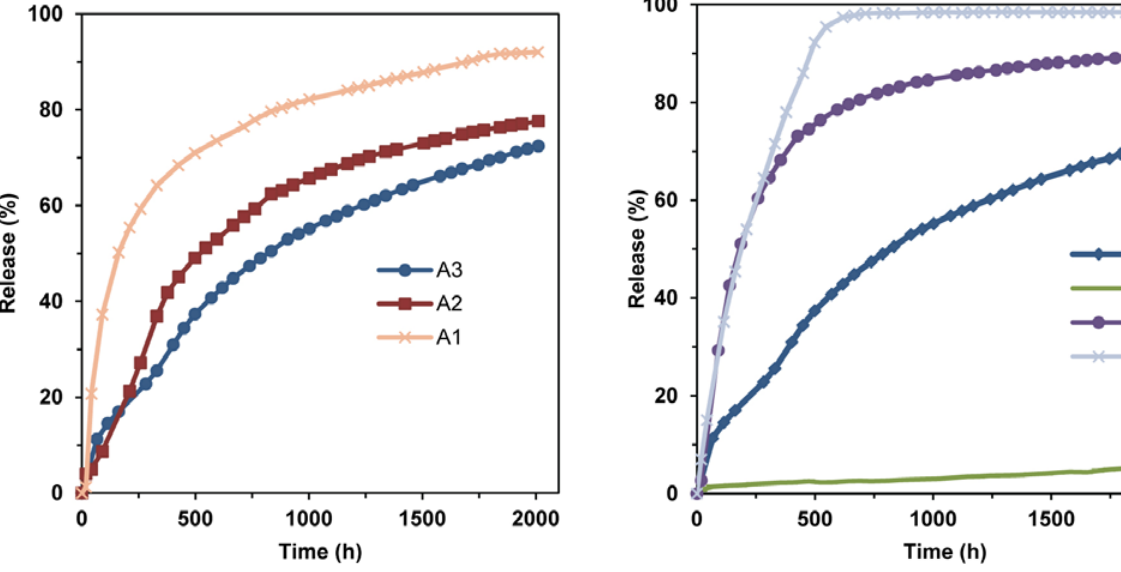
Figure 5. Release rate of the orange oil from the polyurea micro- capsules with different membrane thicknesses (A1 < A2 < A3) and chain extender EDA. The release was measured gravimetrically at 50 °C for 84 days.